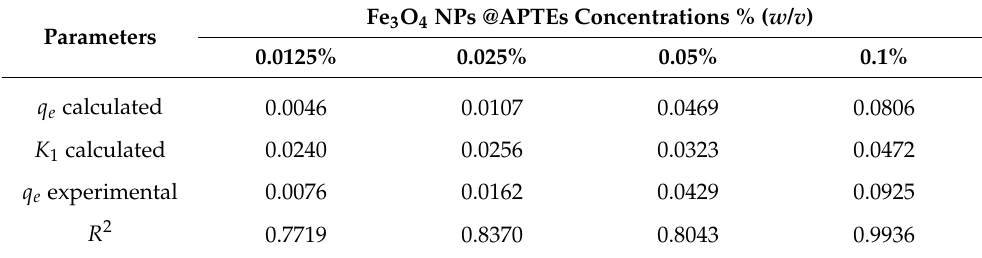
Table 2. Experimental and PFO parameters for Fe 3 O 4 NPs @APTES at four different substrate concentrations % ( w / v ). [ C o = 0.1 mg/L; mixing rate: 200 rpm; T = 18 ◦ C; pH = 5.0].